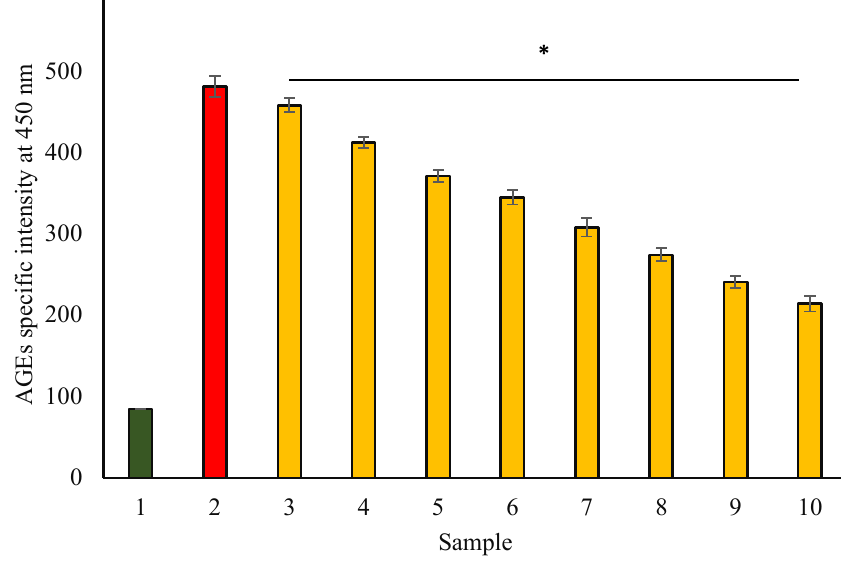
Figure 10. Fluorescence intensity at 450 nm vs. sample—Sample 1 (green pattern) shows native BSA that was incubated alone for 15 days, sample 2 (red pattern) represents BSA kept with glucose in the absence of myrrh extract for 15 days, samples 3 to 10 at X-axis indicate BSA kept for 15 days with glucose and myrrh extract’s various concentrations (50, 75, 100, 200, 300, 400, 500, and 600 µ g/mL) (yellow pattern). The data are shown as means ± standard error of the means (n = 3, p < 0.05). The statistical differences are represented with an asterisk (*) for myrrh denoting significance at p < 0.05 in comparison with the reference sample.